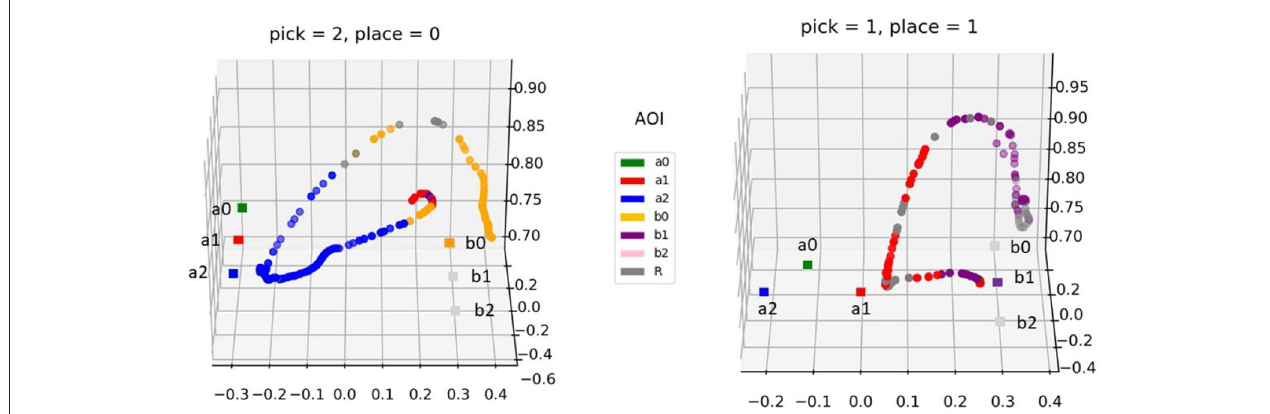
FIGURE 4 | Two exemplary trajectories of the hand during the pick-and-place tasks (left: pick in position 2 and place in position 0; right: pick in position 1 and place in position 1). The movement samples are colored with the currently gazed AoI (see legend). The square markers denote the picking and placing positions: the former are here denominated and colored as the respective AoIs, for the latter only the current placing target is presented in color (the other targets are in light gray since they were not visible but their position is shown for reference).